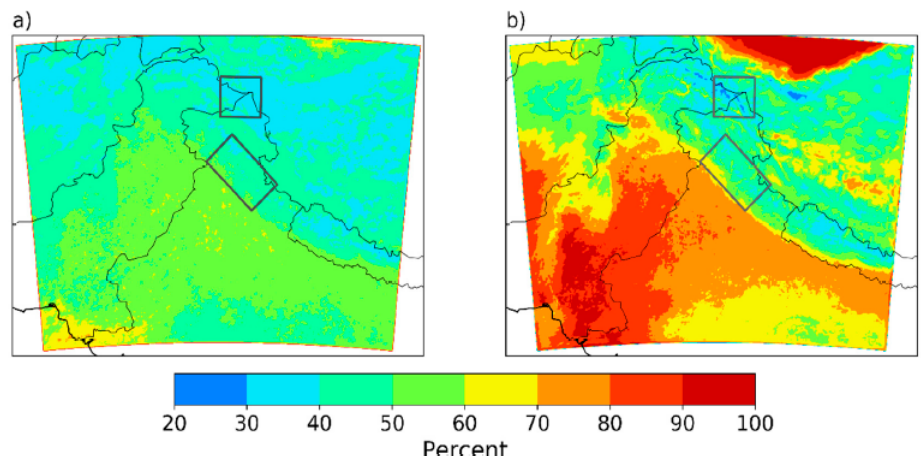
Figure 6. Percentage of annual precipitation produced during and ( a ) top-decile precipitation days in each year and ( b ) the 5 largest 96-h precipitation events. Boxes indicate Karakoram (top) and western Himalaya (center) subregions.